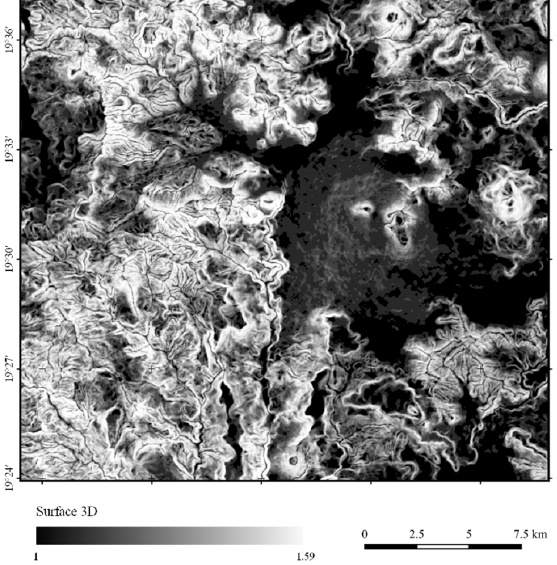
Figure 15 . Fractal dimension applied to the DEM (20 m).